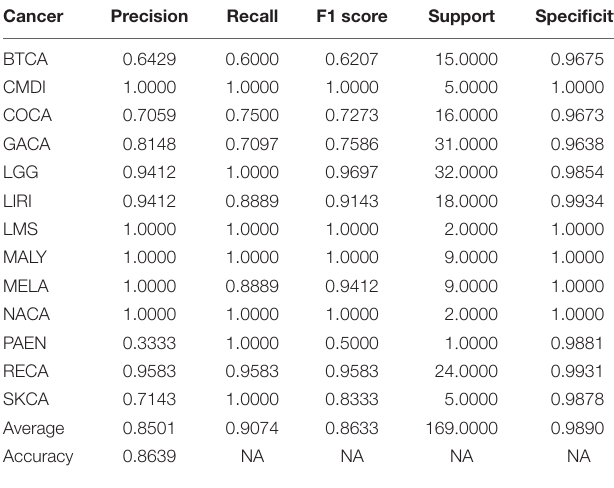
TABLE 3 | Performance metric of test dataset using top 500